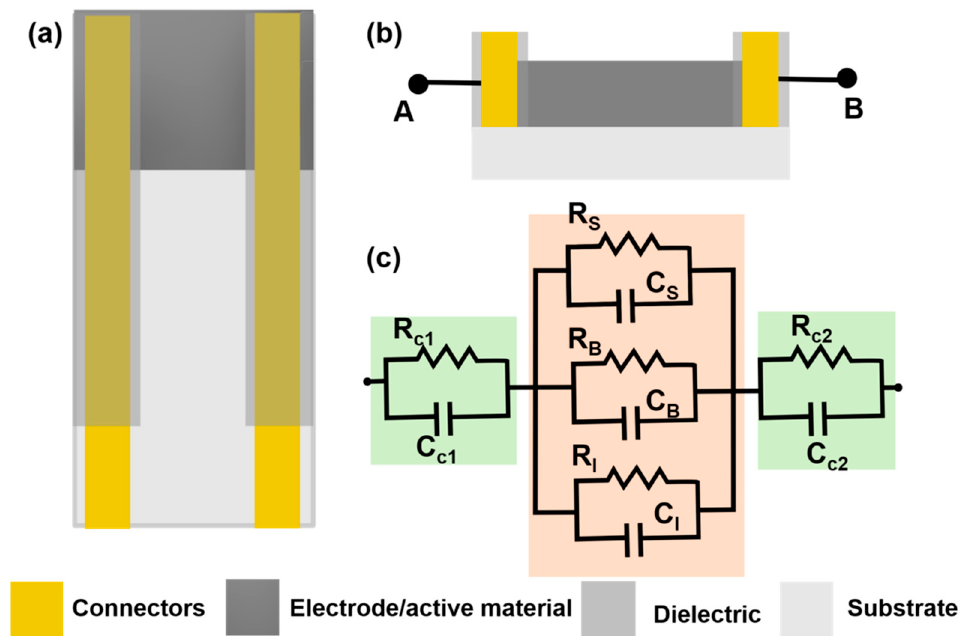
Figure 2. ( a ) Top view of a chemiresistive sensor with 4 main components: active material (dark grey), connectors or contacts (gold), dielectric to insulate the contacts (grey) and substrate (light grey) ( b ) A transverse section of a chemiresistive sensor with two connecting outputs ( c ) An electrical circuit analog for the chemiresistive sensor with R c1 and R c2 , the contact resistance for the first and second contacts, while R S , R B and R I are the solution, bulk and interfacial resistance. Similar to resistance, capacitance of all the surfaces are labelled accordingly.